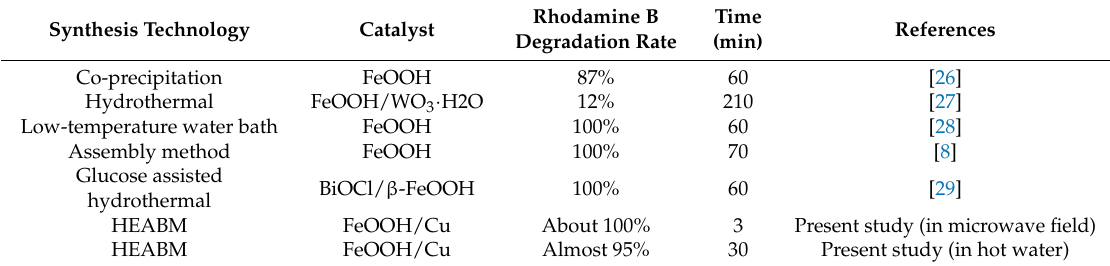
Table 1. Catalytic activity of FeOOH synthesized by different approaches for degrading Rhodamine B.